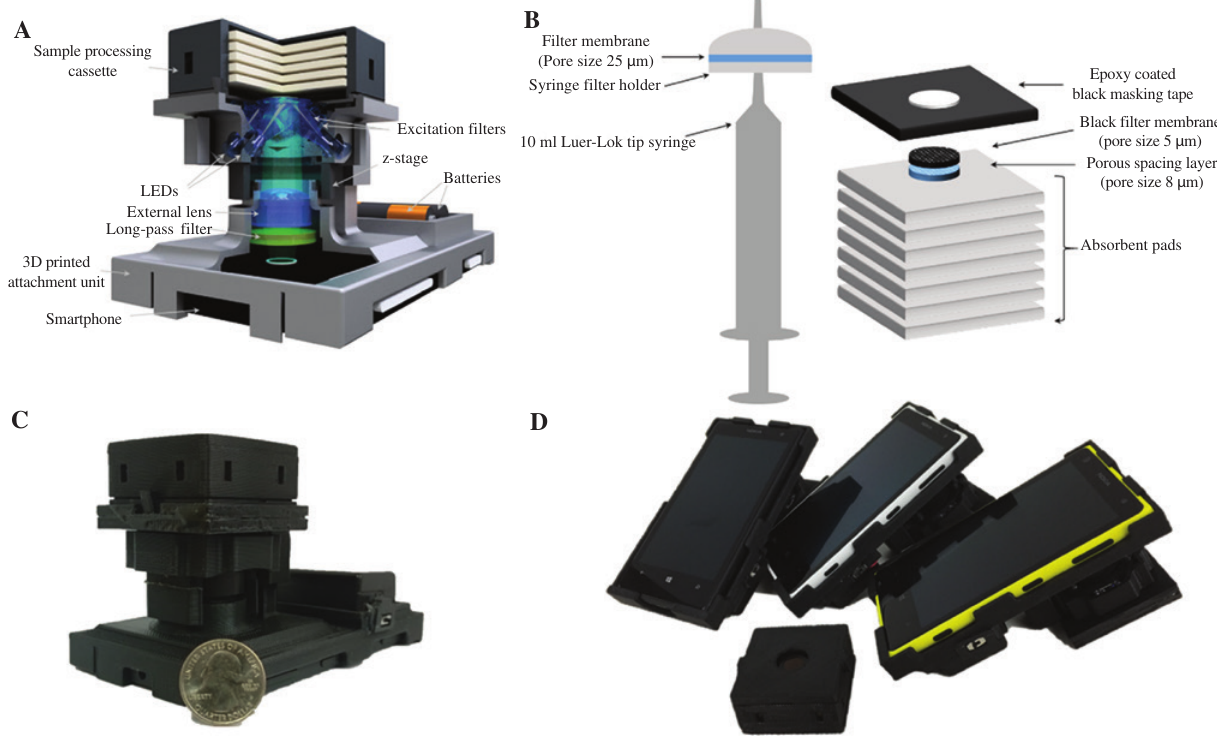
Figure 1: (A) Schematics of our smartphone-based pathogen detection platform with its illumination path, and (B) the contents of a pre- filtration unit and a disposable sample processing cassette. (C, D) Photographs of the platform and three prototypes used throughout our experiments. These mobile phone-based sensing devices follow our previous design reported in [11], and in this work, we quantified the impact of device-to-device, phone-to-phone as well as image file format-related variations on the performance of our mobile sensor platform using various water samples, including, e.g. tap water, non-potable water, and pond